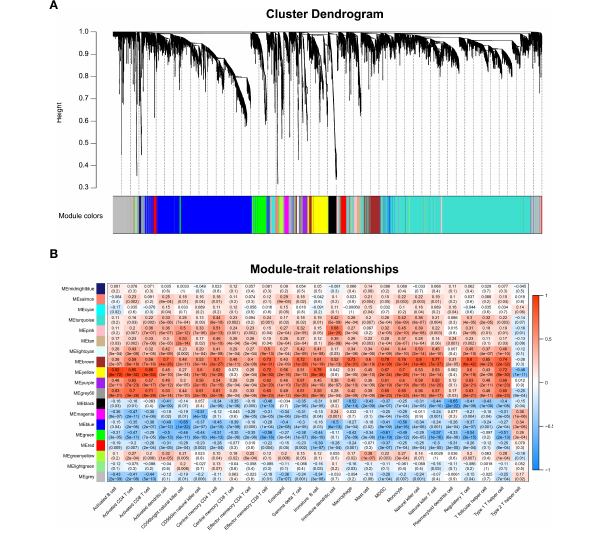
FIGURE 2 WGCNA and identi fi cation of the key module associated with immune in fi ltration in RA. (A) Clustering dendrograms for the 3,784 DEGs with dissimilarity based on the topological overlap together with the assigned module colors; 19 co-expression modules were constructed with various colors. (B) Heatmap of the correlation between module eigengene and differentially in fi ltrated immune cells. Each row represents a color-coded module eigengene, each column represents a type of in fi ltrated immune cells. The number in each cell means the correlation coef fi cient and